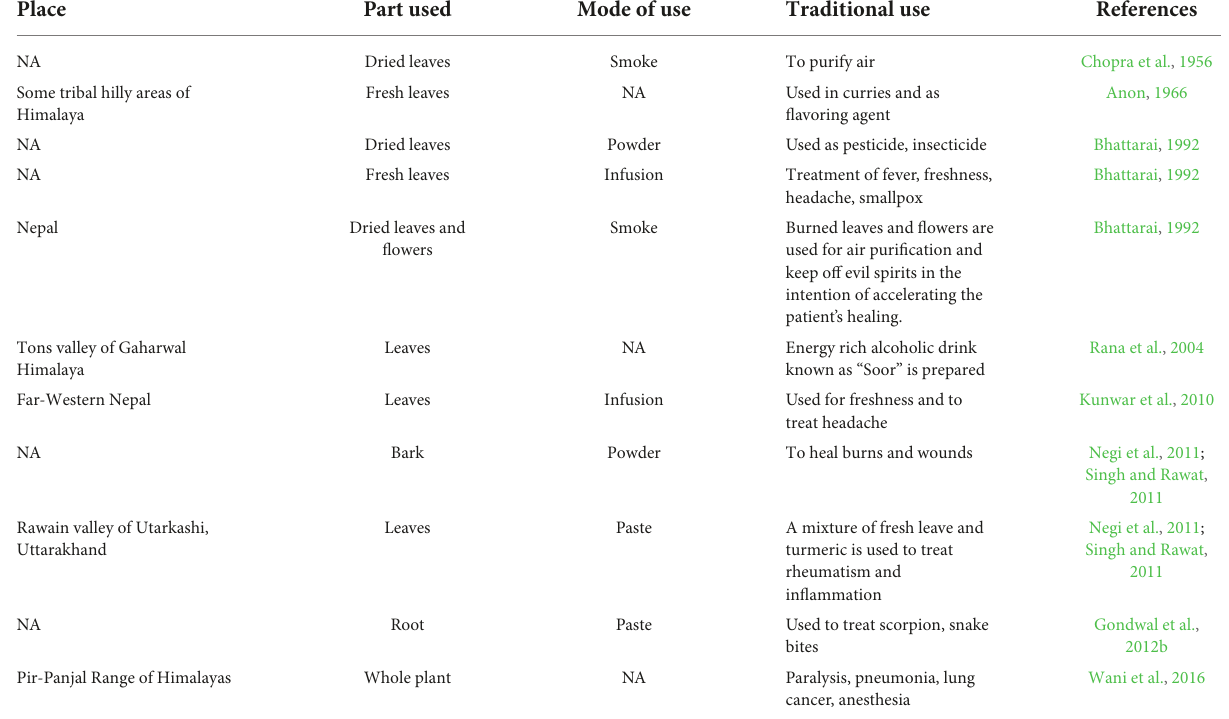
TABLE 1 Traditional uses of Skimmia anquetilia